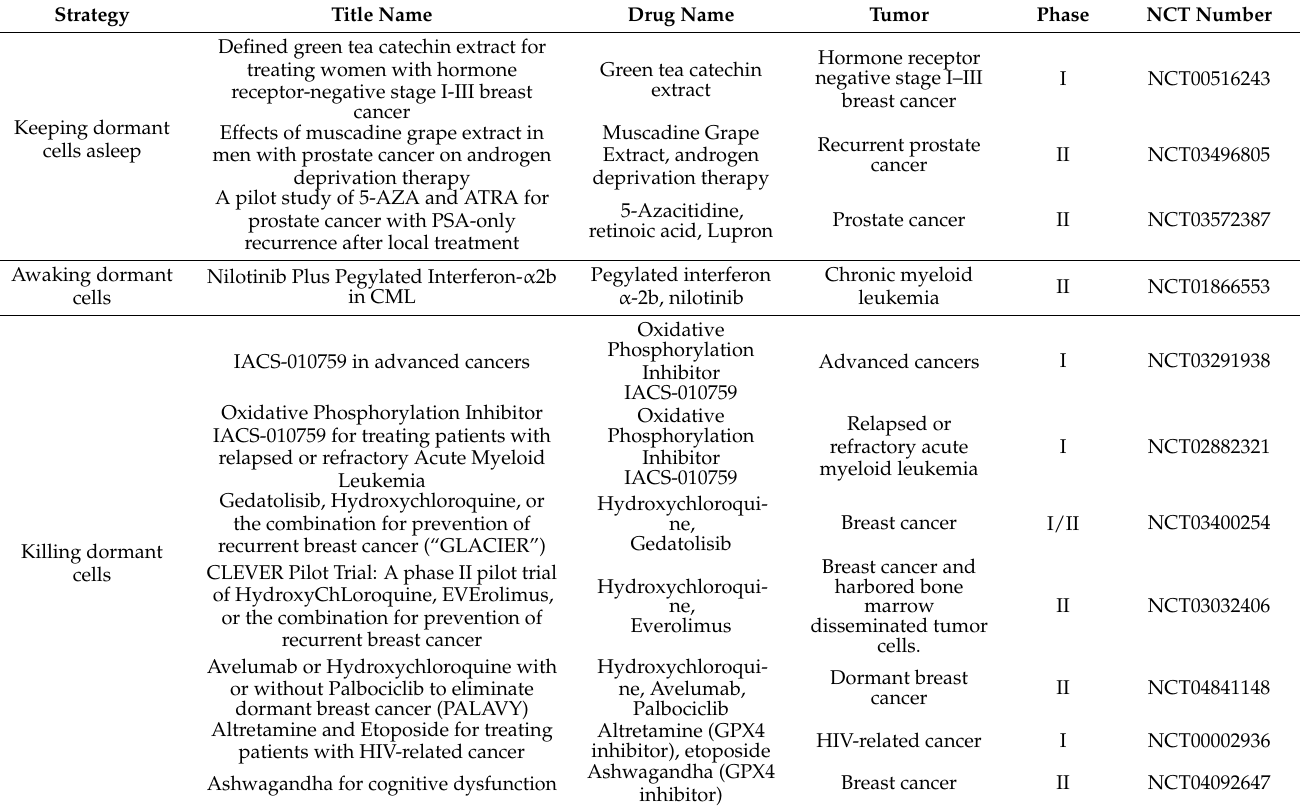
Table 1. Summary of clinical trials targeting dormant cancer cells from redox